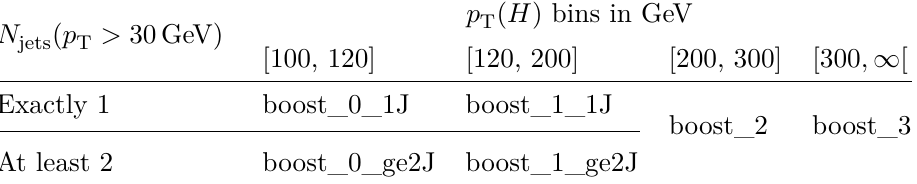
Table 6. Definition of the six categories in the boosted phase